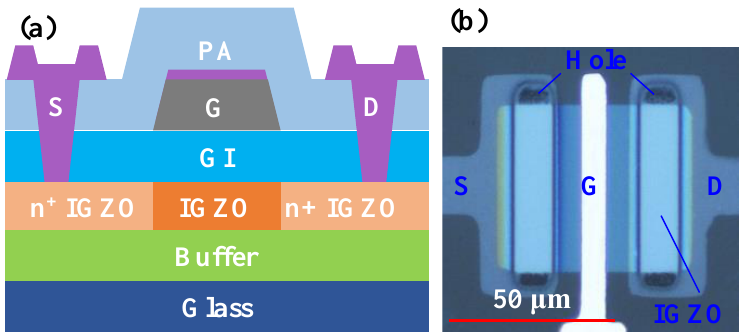
Figure 1. ( a ) The schematic diagram of SATG IGZO TFTs. ( b ) Top view of SATG IGZO TFT. The electrical characteristics for the fabricated a-IGZO TFTs were measured using Keithley 4200. We define the corresponding gate voltage ( V GS ) when the leakage current ( I DS ) is 1 nA as the threshold voltage ( V TH ) of the TFT device. The mobility ( µ ) was calculated according to the following equation: µ = 2 L · I DS / W · C i · ( V GS − V TH ) 2 , where C i is the gate of the capacitance per unit area. The sheet resistance was measured by the 3 m mini type four-probe tester in the dark at 300 K. The light source used in the NBIS tests